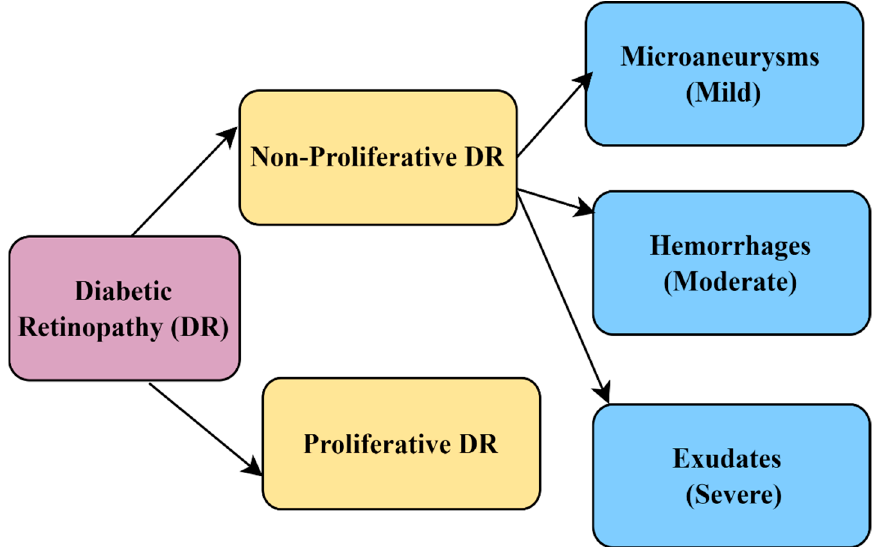
Figure 4. Stages of DR [25].